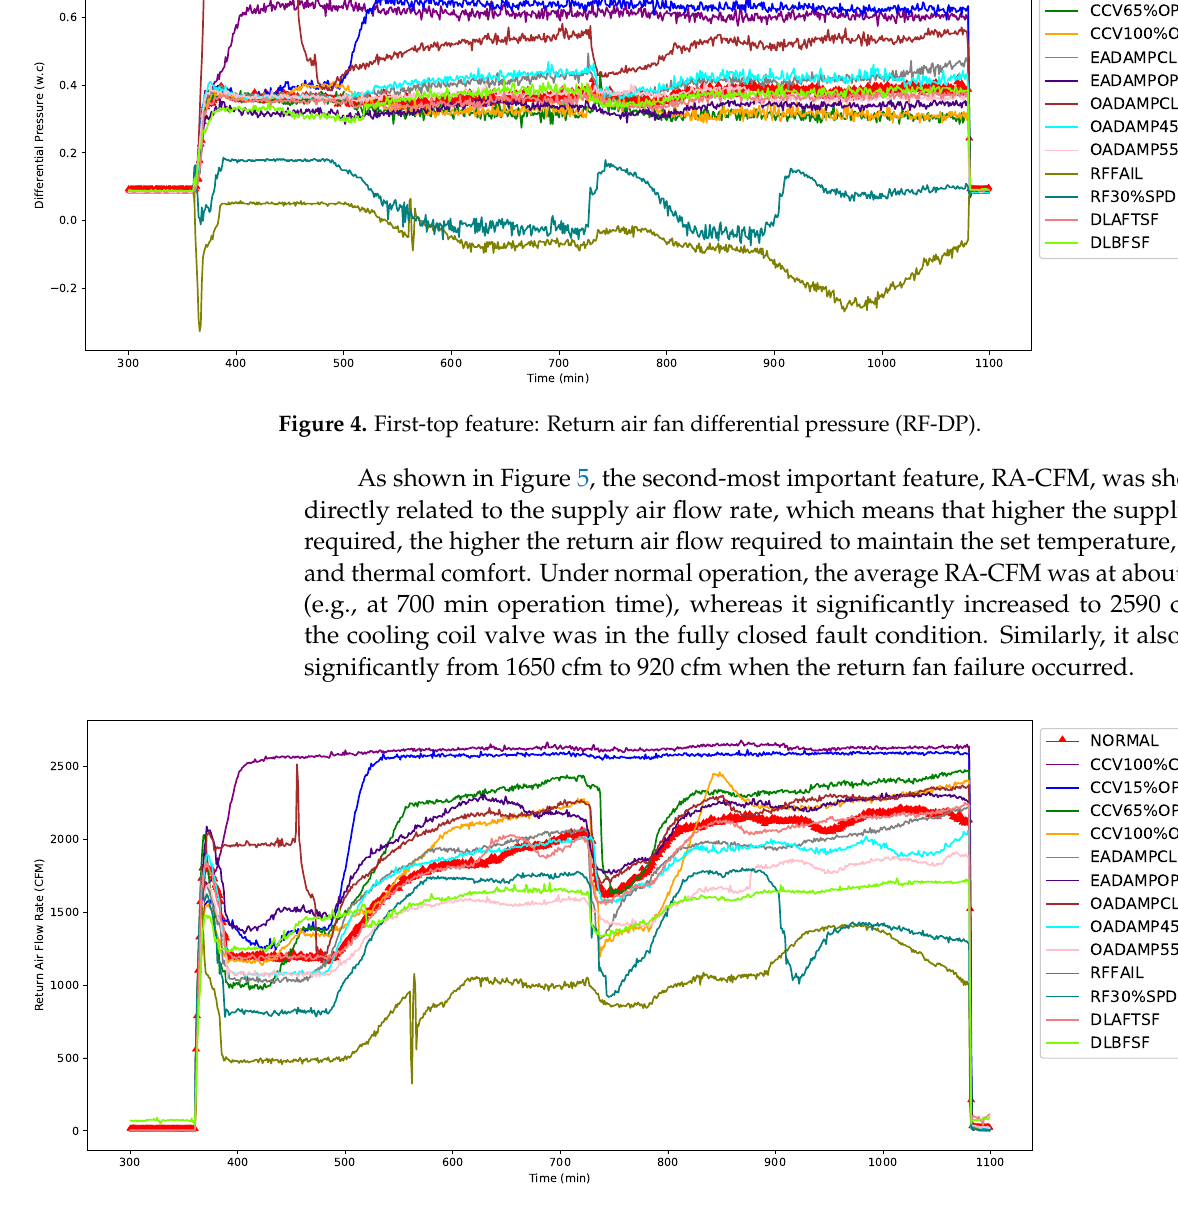
Figure 5. Second-top feature: Return air flow rate